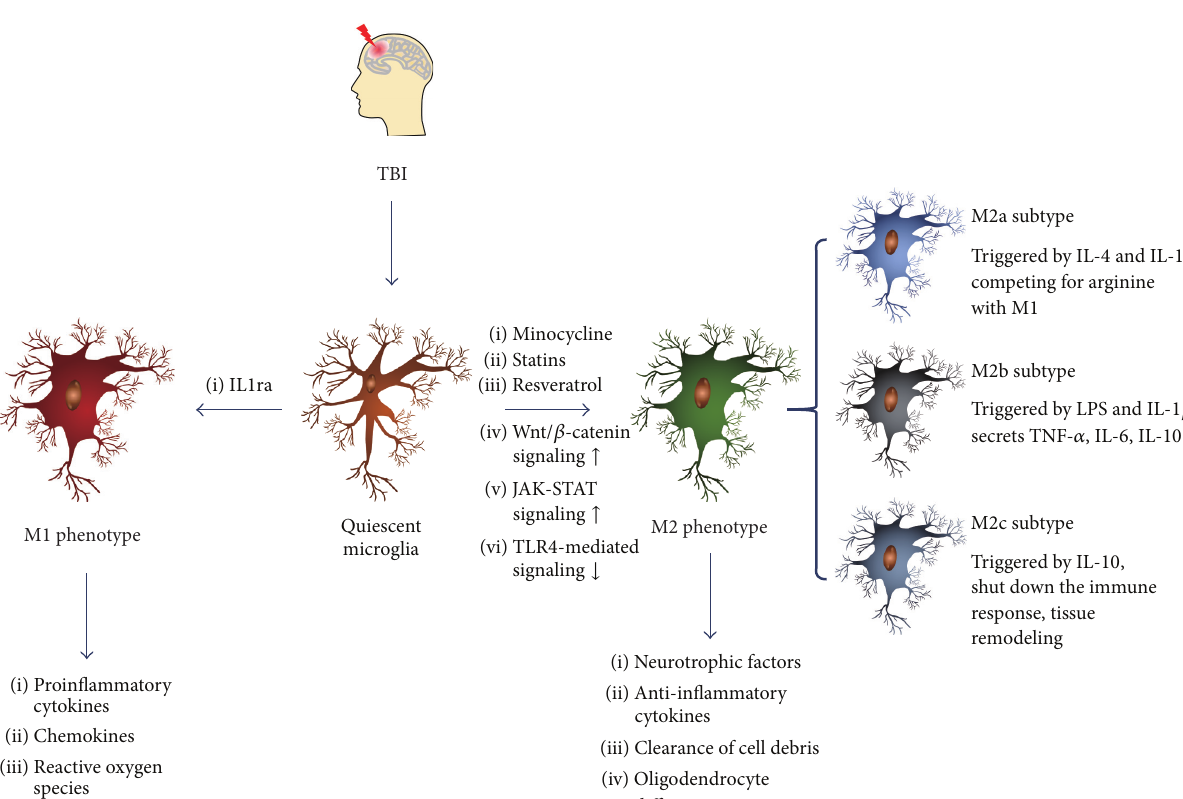
Figure 1: Two distinct polarization states of activated microglial cells and the three different subtypes of M2 phenotype microglia.